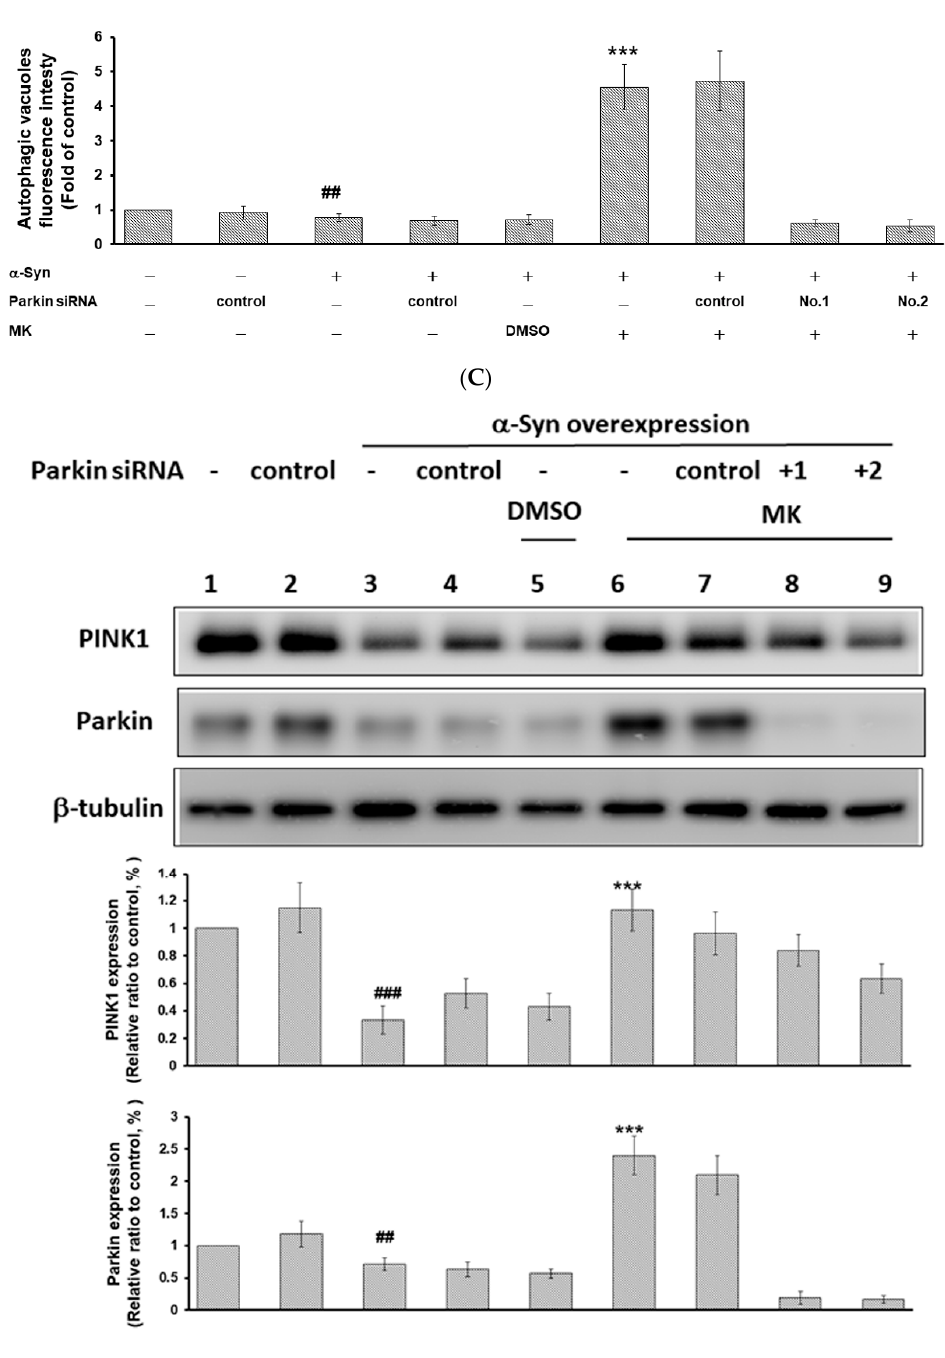
Figure 10. Parkin ‐ siRNA reversed the clearance ability of maackiain (MK) in the α‐ synuclein ( α‐ Syn) ‐ overexpressing SH ‐ SY5Y cell line. α‐ Syn ‐ overexpressing SH ‐ SY5Y cells were transfected with control siRNA or parkin ‐ siRNA for 24 h. Transfected Cells were incubated with 1 µM MK for 24 h. ( A ) A representative fluorescence image of α‐ Syn ‐ overexpressing SH ‐ SY5Y Cells. Recombinant α‐ Syn was detected by Myc antibody (Green). Hoechst 33258 was used as a marker of nuclear morphology (blue). ( B ) Suc ‐ Leu ‐ Leu ‐ Val ‐ Tyr ‐ AMC was used as a substrate to measure proteasome activity. The relative fold proteasome activity is represented as the ratio relative to the control experiment. ( C ) Autophagic vacuoles were observed by using acidic vesicular organelle (AVO) staining. Top, representative phase contrast images and fluorescent images; bottom, the fluorescence intensity of acridine orange (0.5